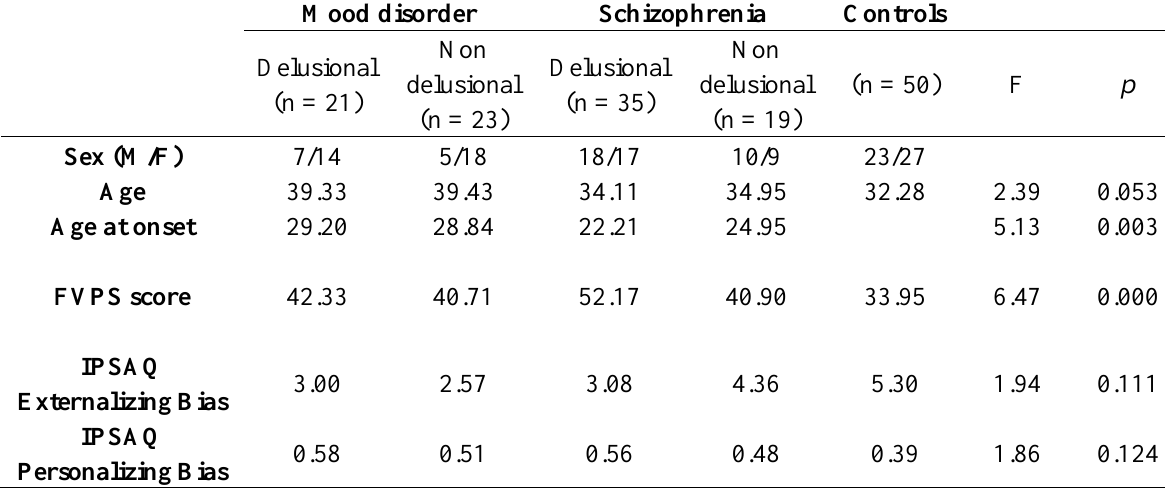
Table 1. Clinical and demographic characteristics of the patients and scores in the Fenigstein and Vanable Paranoia Scale (FVPS) and Internal, Personal and Situational Attribution Questionnaire (IPSAQ) questionnaires.